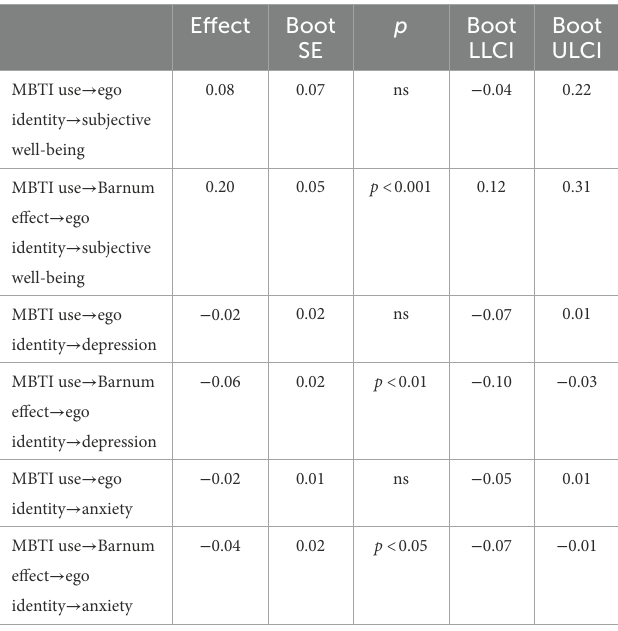
TABLE 4 Significant results of sequential mediation models.